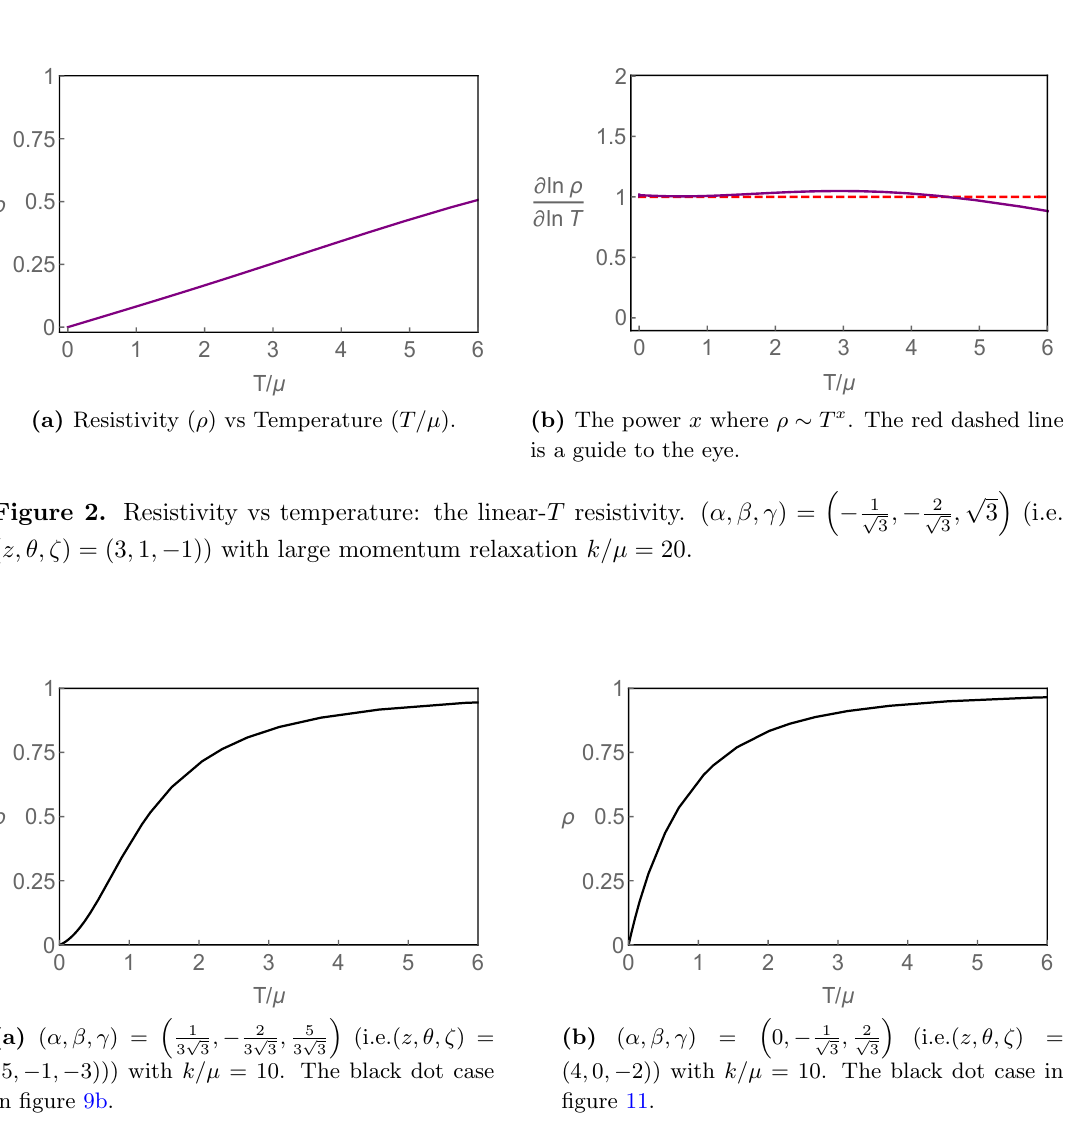
Figure 3. Resistivity vs temperature: non-linear- T